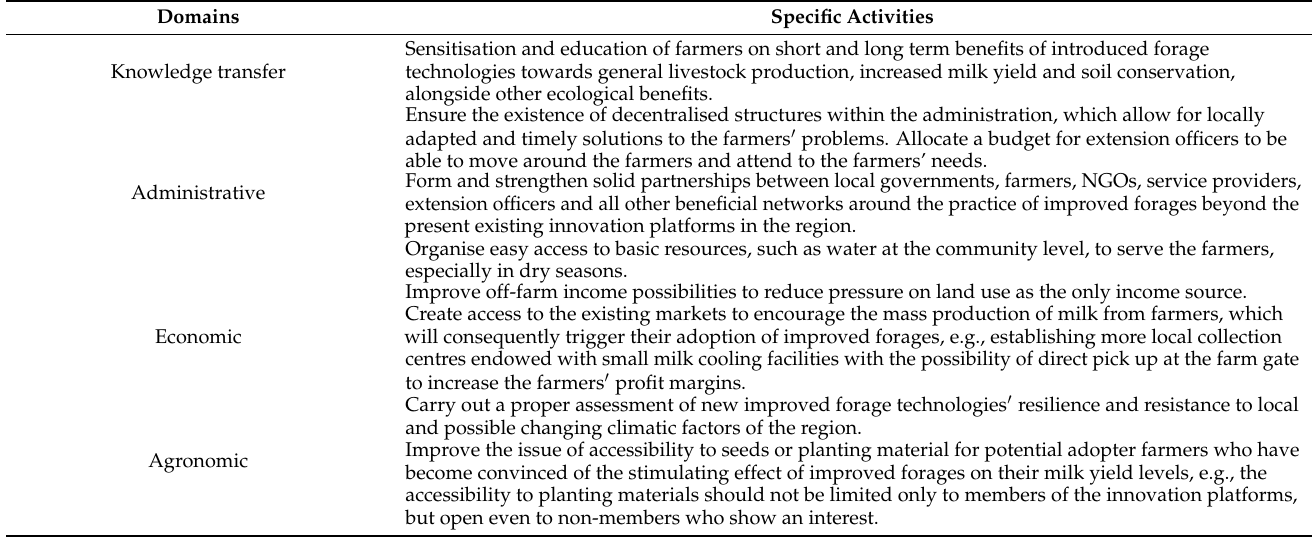
Table 3. Recommended domains for improvement and related